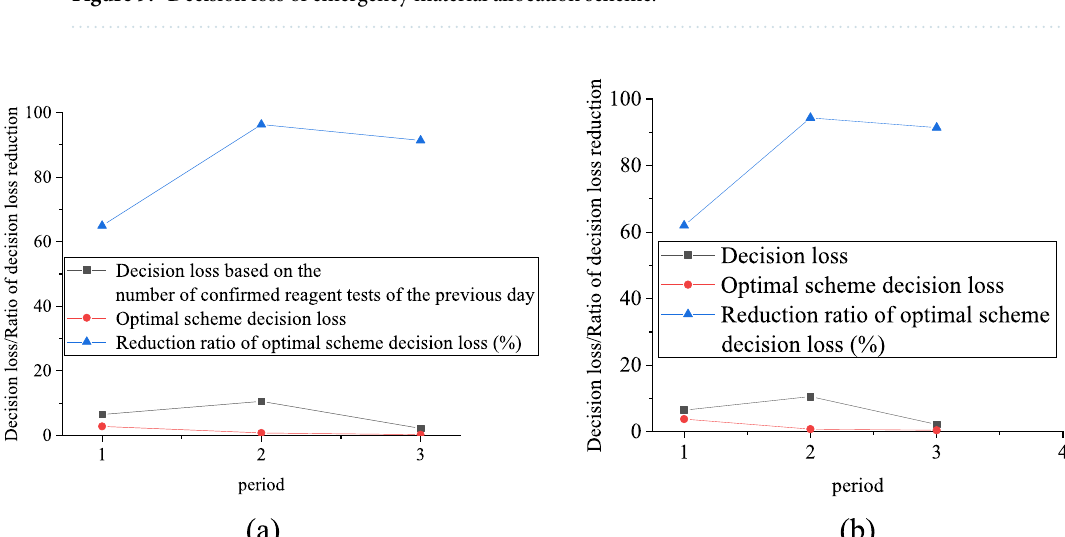
Figure 10. Comparison of decision-making losses in emergency material allocation plans. ( a ) The proposed algorithm; ( b ) The algorithm proposed in 33